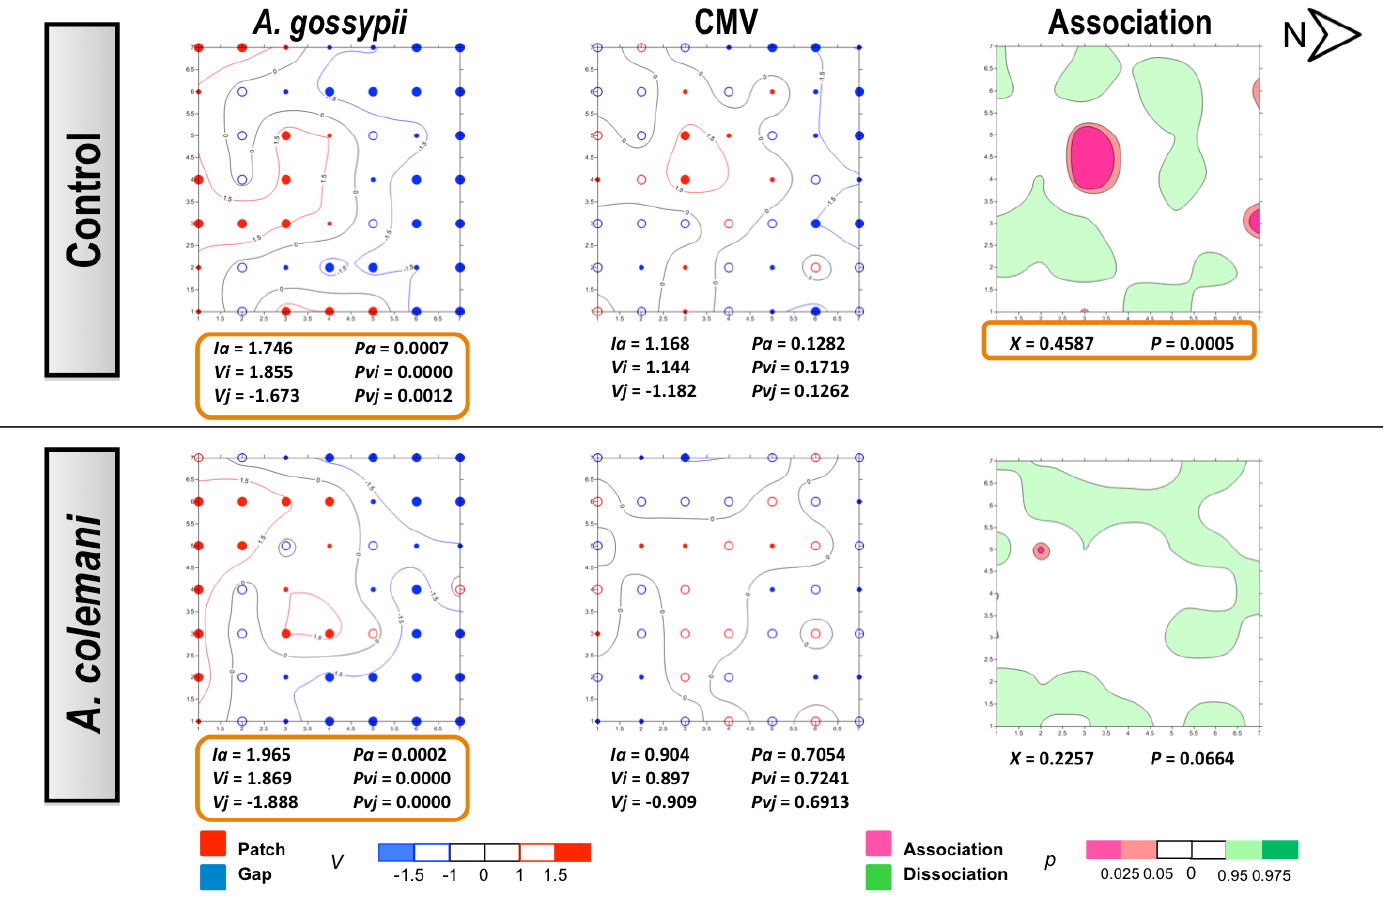
Figure 4. Classed post maps of the spatial distribution of mean number of A. gossypii and cumulative number of CMV-infected plants (total number of infected plants per treatment) at 7 days, and contoured map of the association between CMV-infected plants and its vector, A. gossypii . Symbols and contours are as for Figure